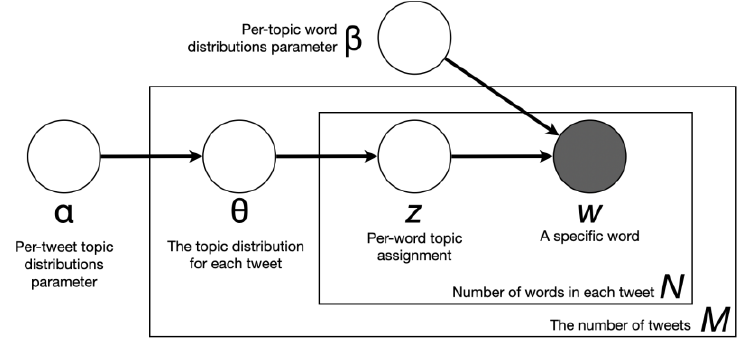
Figure 2. Graphical representation of LDA.